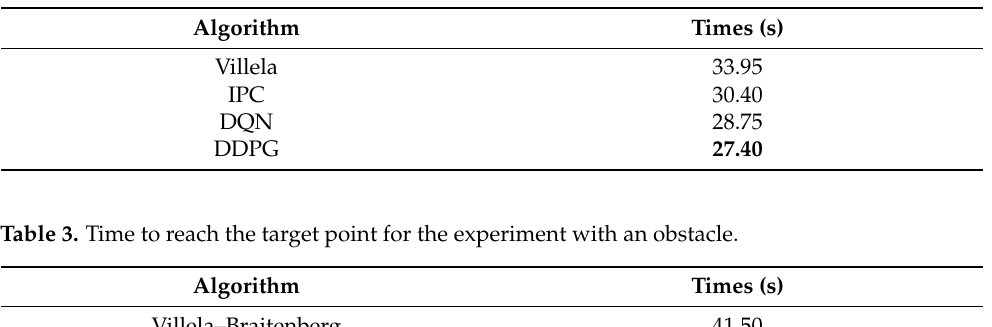
Table 2. Time to reach the target point for the experiment without an obstacle.